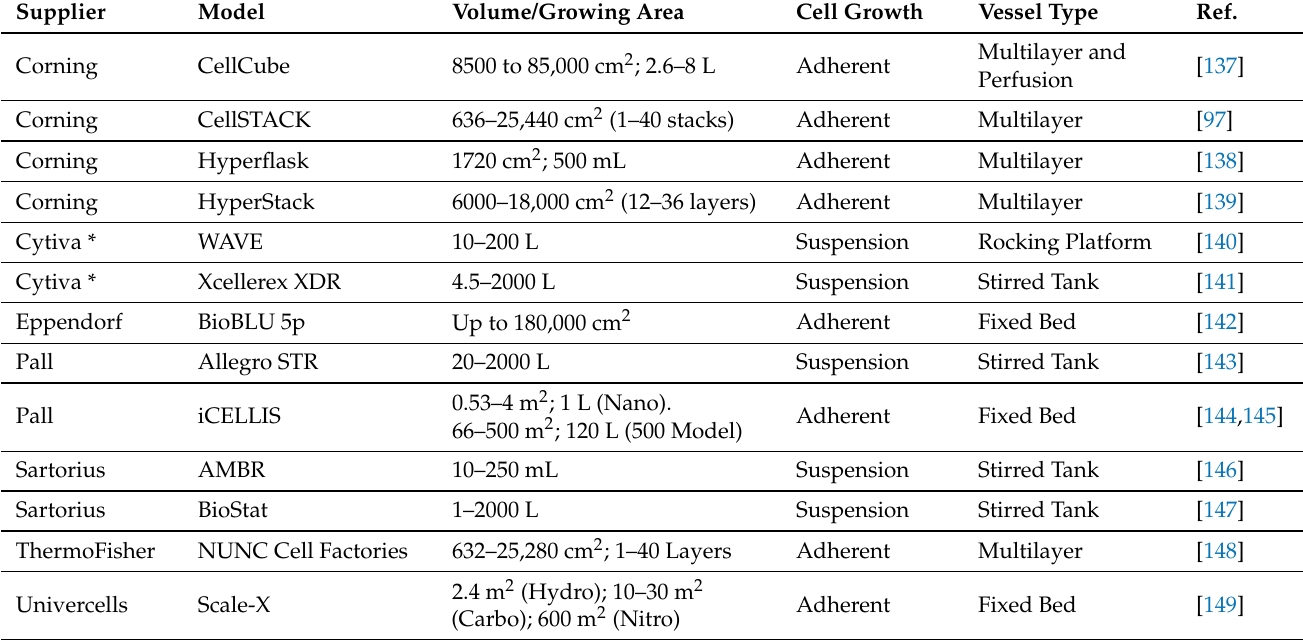
Table 4. Examples of upstream cell culturing for the production of lentviral